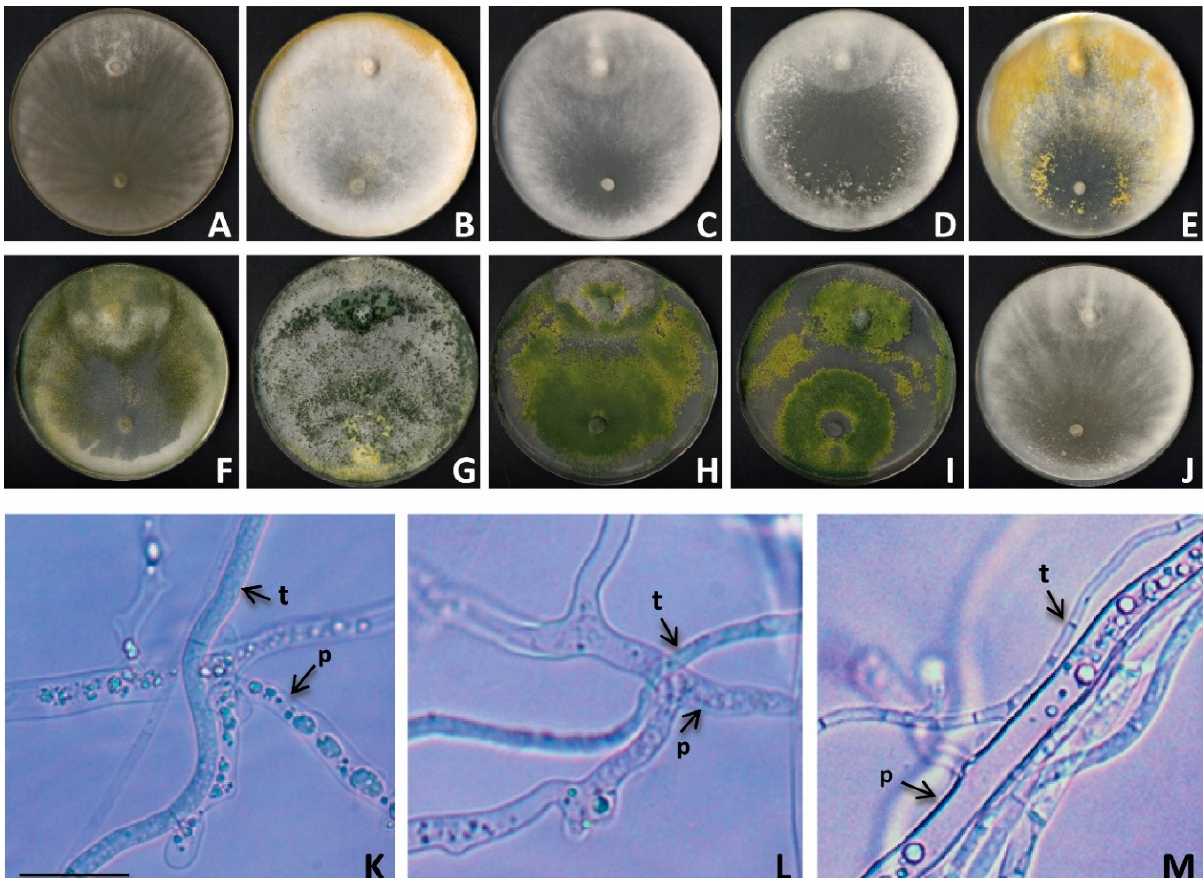
Figure 4. Mycoparasitism of Trichoderma strains against P. cinnamomi in dual cultures. ( A – J ) Physical interactions after 14 days on PDA between P. cinnamomi (up) native strain and Trichoderma spp. (down) ( A – C , E , J : T. gamsii , D : T. viridarium , F : T. olivascens , G : T. hamatum , H : T. linzhiense , I : T. hirsutum ). ( K – M ) Micrographs of the interaction zone. ( K , L ) = hyphal coiling and vacuolated hyphae. ( M ) = adhered hyphae growth. p, P. cinnamomi . t, Trichoderma . Scale = 250 μ m.